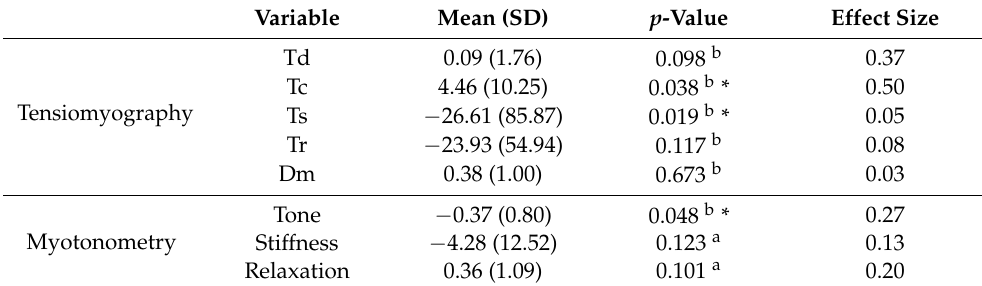
Table 3. Differences between